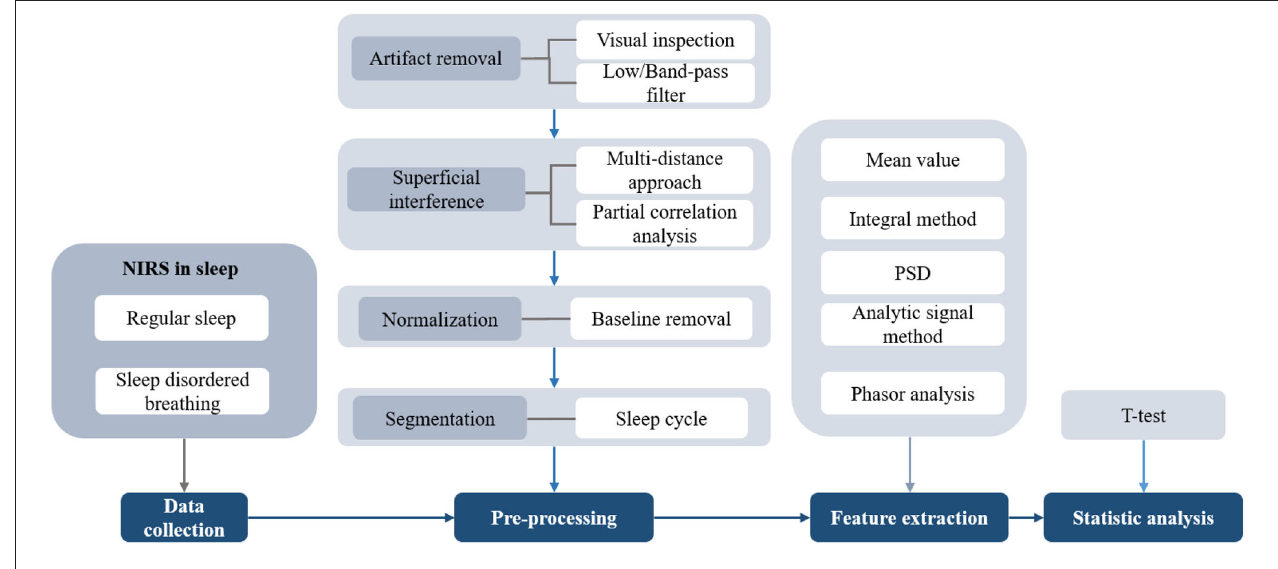
FIGURE 7 | The flowchart of signal processing in sleep using NIRS.